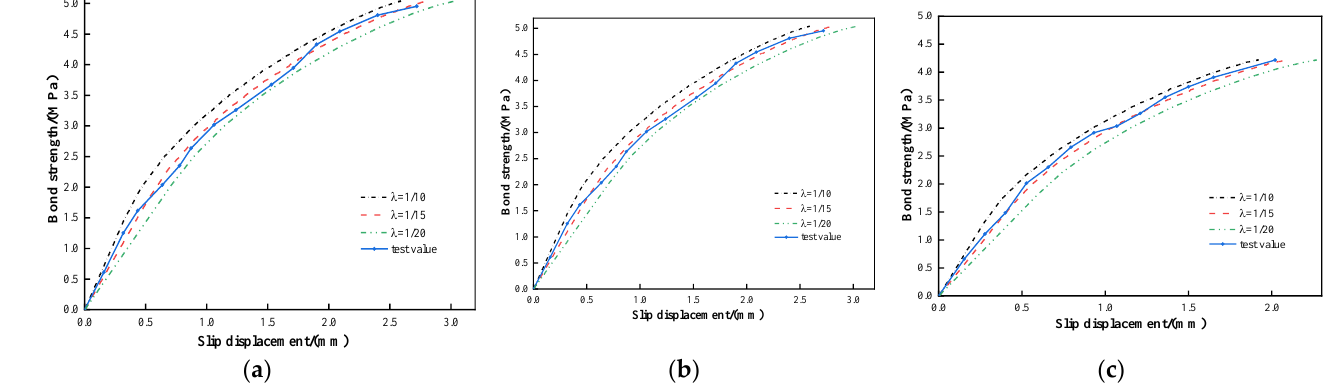
Figure 10. Inverse analysis results of the grout stiffness. ( a ) M20-22. ( b ) M20-25. ( c ) M20-28.